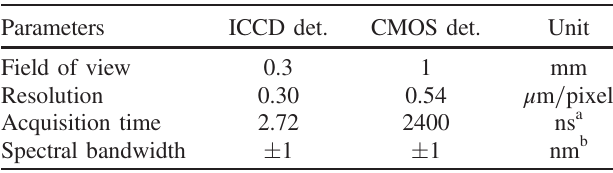
TABLE VI. IP imaging optical system parameter. Parameters ICCD det. CMOS